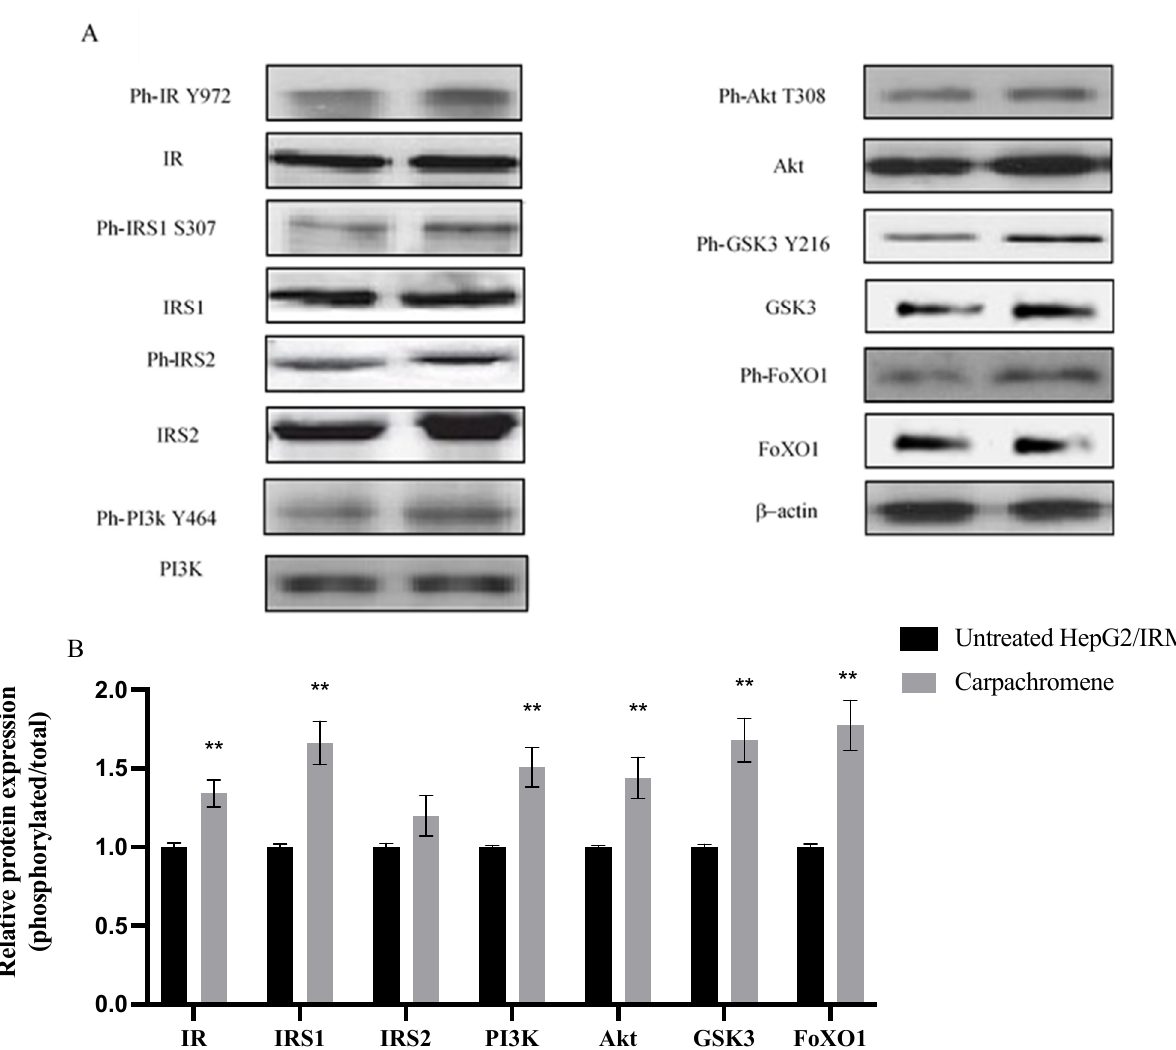
Figure 5. Effect of Carpachromene on the expression of phosphorylated and total proteins of IR, IRS1, IRS2, PI3K, Akt, GSK3, and FoxO1 proteins in HepG2/IRM cells. ( A ) Representative Western blots of phosphorylated and total proteins of IR, IRS1, IRS2, PI3K, Akt, GSK3, and FoxO1 in HepG2/IRM cells before (left lane) and after (right lane) treatment with 20 μ g/mL carpachromene. β -actin was used as internal loading control. ( B ) Phosphorylated/total protein expression ratio in HepG2/IRM cells relative to untreated HepG2/IRM cells, after normalization to the corresponding β -actin protein expression. Bars represent mean ± SD. Significant difference was analyzed by student t test, where ** p < 0.01, compared to untreated HepG2/IRM cells.